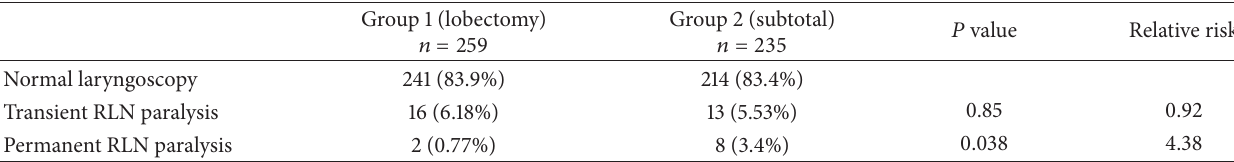
Table 2: Incidence of RLN injury following reoperative surgery.